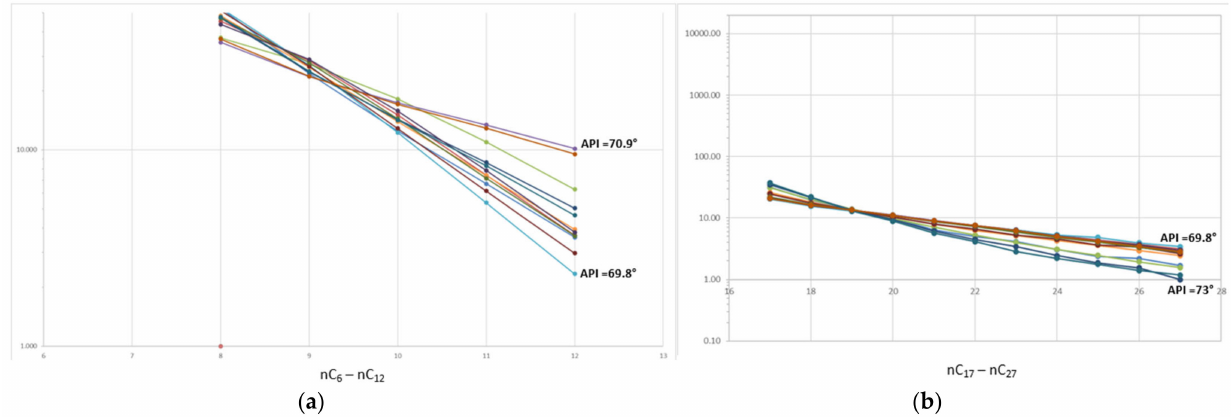
Figure 14. Normalized percent molar n-alkanes plotted against carbon number for Marcellus For- mation condensates collected in the wet gas-producing region. % molar n-alkanes = A*e-B*C n where A and B are regression factors used for correlation to oil parameters of interest (API, GOR,